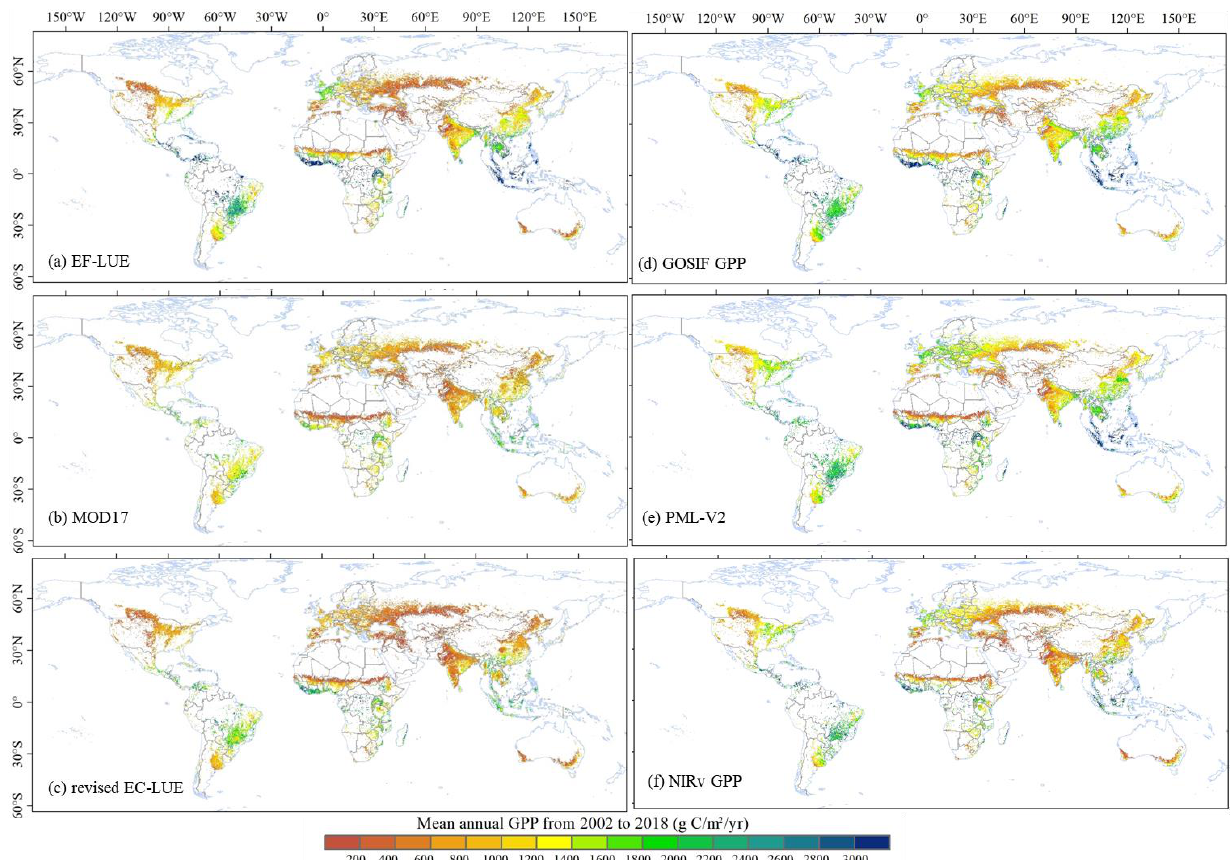
Figure 7. Spatial pattern of global mean annual GPP of cropland (average over 2002–2018) estimated by ( a ) EF-LUE, ( b ) MOD17, ( c ) revised EC-LUE, ( d ) GOSIF GPP, ( e ) PML-V2 GPP, and ( f ) NIRv GPP.